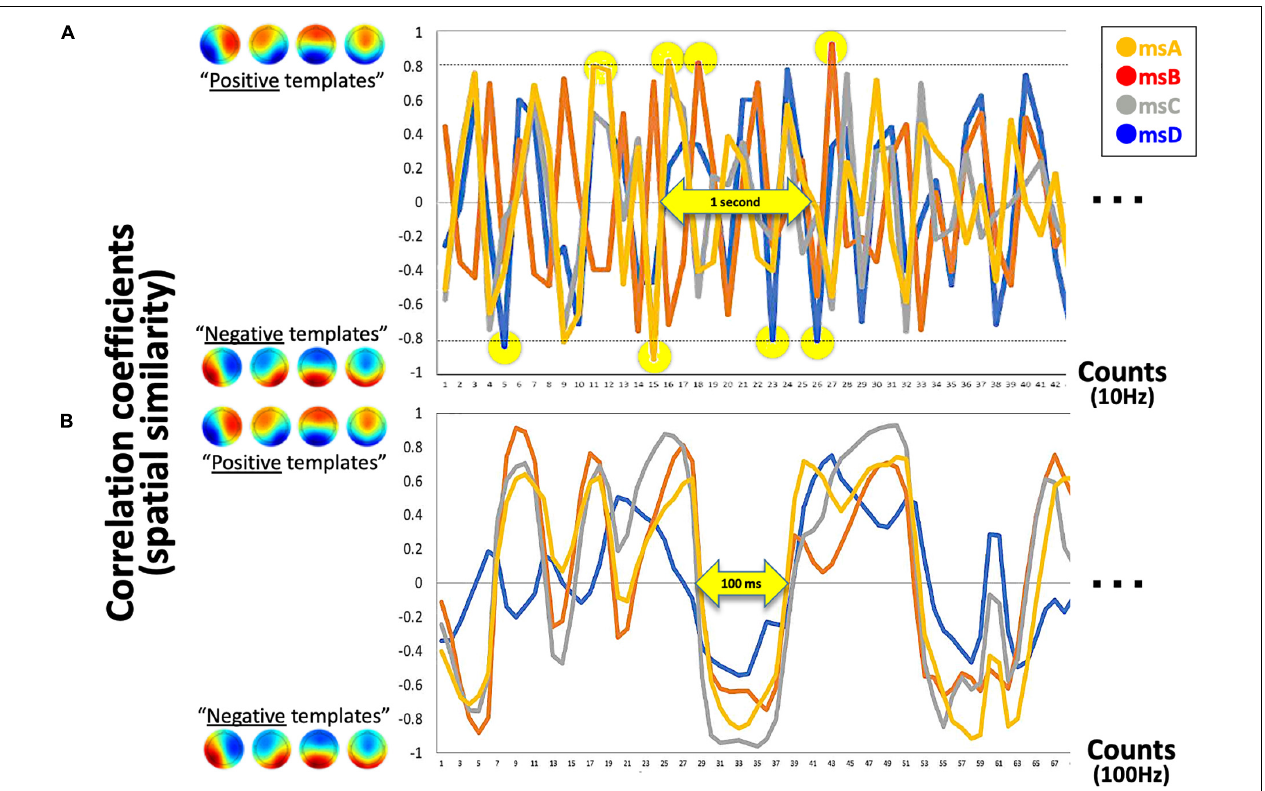
FIGURE 3 | Detected canonical msABCD templates. (A) The exemplified time series of four correlation coefficients with template msABCD at 10 Hz is shown. The yellow circle indicates the detected canonical microstates in real-time (when r thr = 0.8). (B) If the system is processed at 100 Hz (for comparison), a continuous state-transition dynamic can be observed. In this sense, our time-averaged 10-Hz system detects only spatio-temporally robust